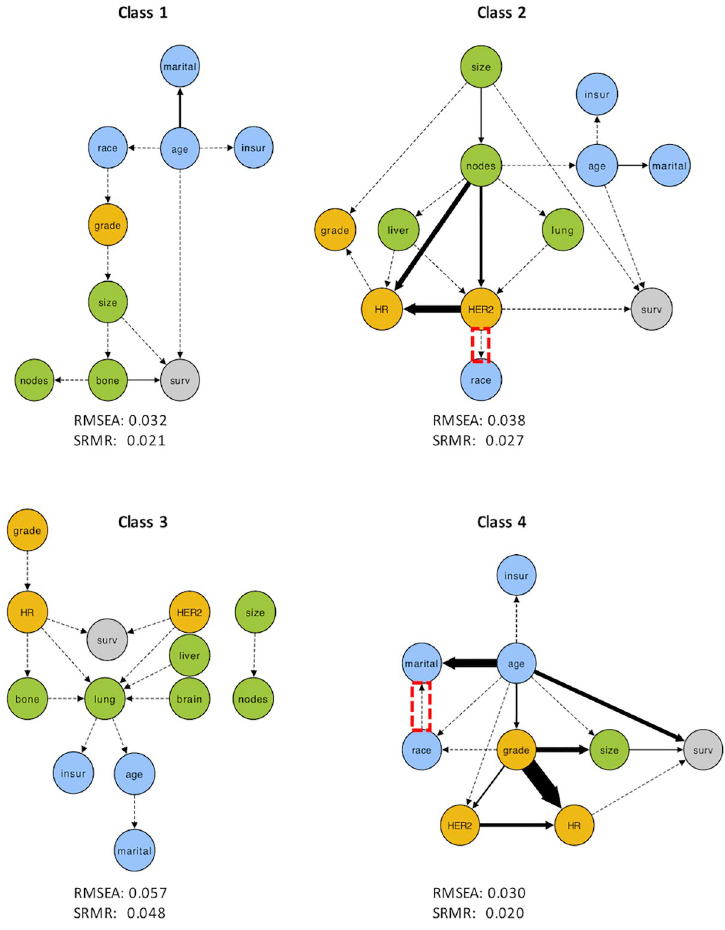
Fig 2. DAG plots for each latent class. Arrow thickness represents the strength of association, which is inversely proportional to BIC. Dotted lines represent associations which are � 5% of the strength of the strongest association. Node colours are grouped as follows: host features (blue), tumour biology (orange), disease burden (green), and overall survival (grey). Red boxes indicate interactions which were not validated by the SEM regression (p > 0.001). RMSEA = root mean square error of approximation; SRMR = standardized root mean square residual; “surv” = survival; “insur” = insurance.